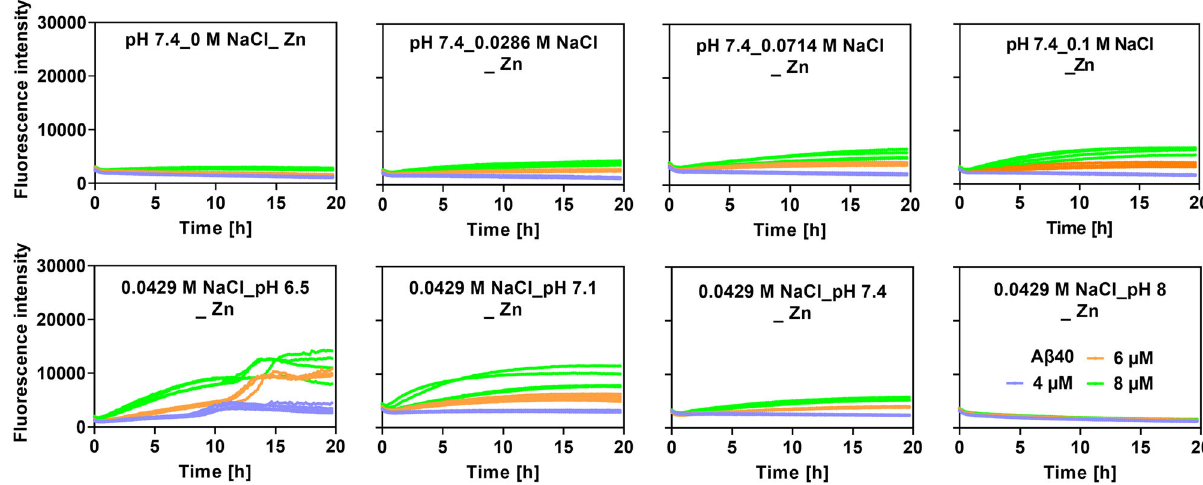
Fig. 2 The multivariate effects of pH, salt, and Zn 2 + ions on A β 40 fi brillation at different A β 40 concentrations (see legends). At 4 µ M, A β 40 displays fi brillation with fl at curve in the presence of 40 µ M Zn 2 + . All original ThT data were smoothed by choosing the Savitzky – Golay method with a points of Window from 5 to 30 using the Origin